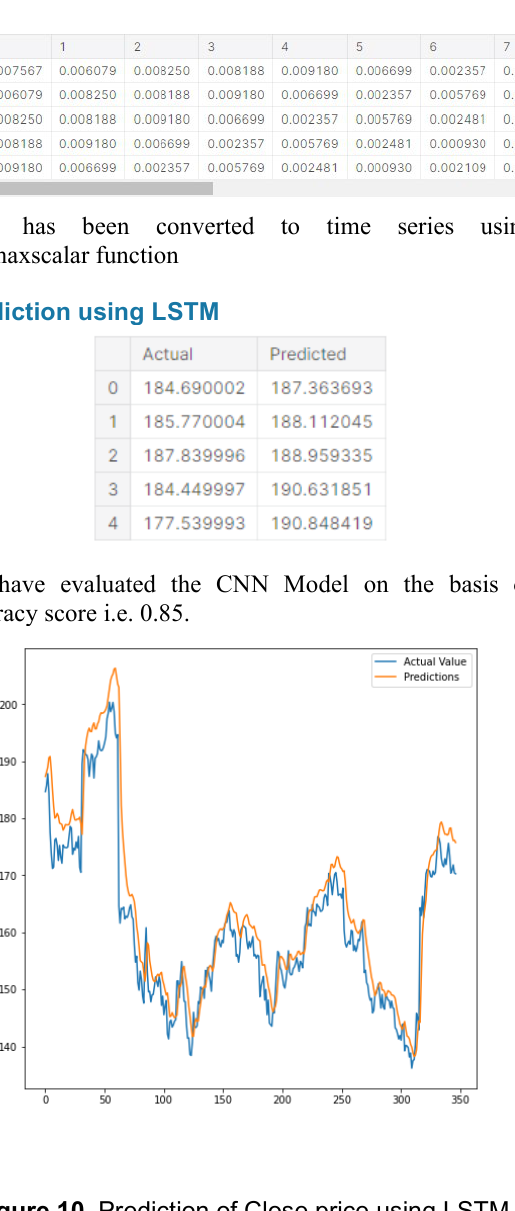
Figure 10. Prediction of Close price using LSTM Prediction using Artificial Neural